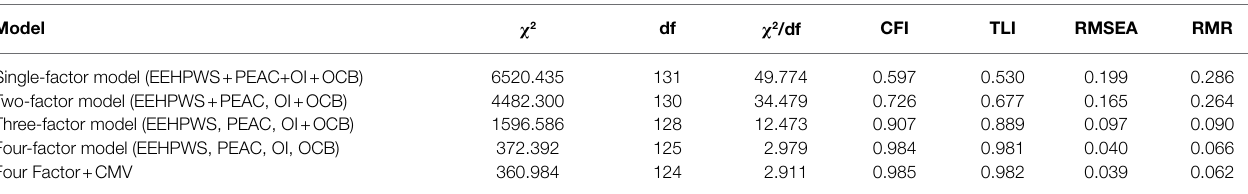
TABLE 2 | Confirmatory factor analysis.